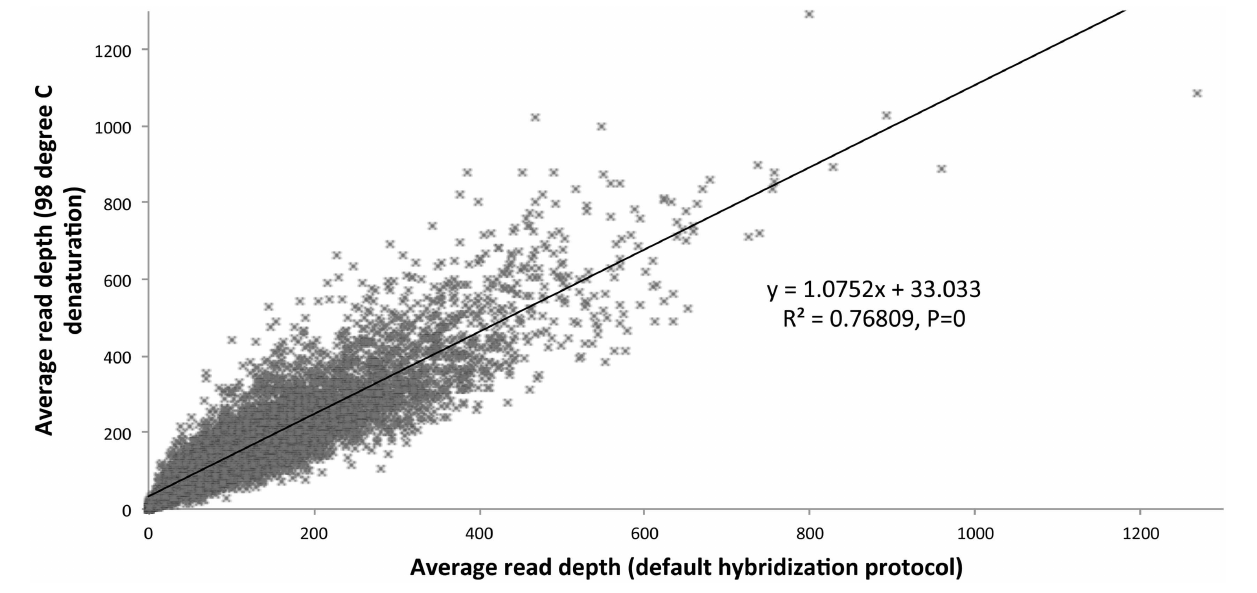
FIGURE 3 |Average read depth compared (default hybridization protocol vs. addition of 2-min 98°C initial denaturation) .